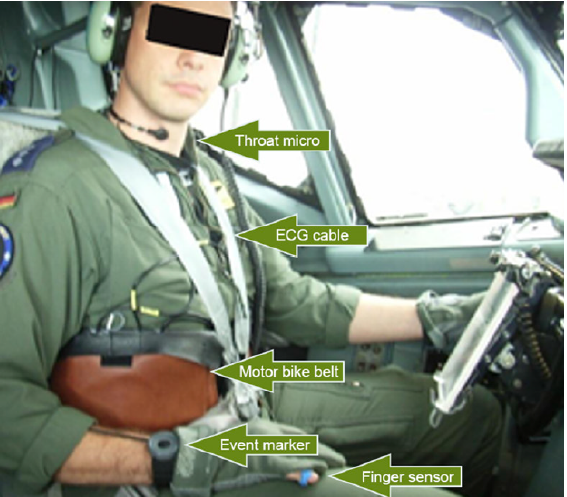
Figure 4. Instrumentation setup employed and shown in [76] for real-time monitoring. The authors registered a single-lead ECG, finger temperature, pulse wave, and